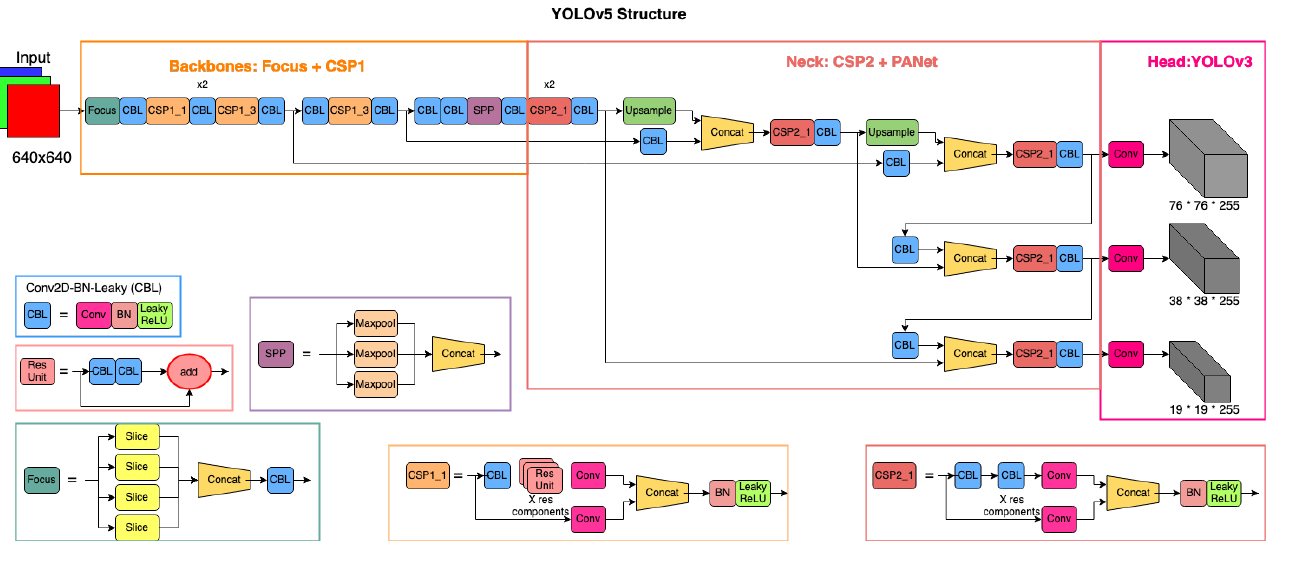
Figure 4. Network architecture of YOLOv5 (adapted from [57] and modified) with a backbone of Focus and CSP and a neck of CSP and